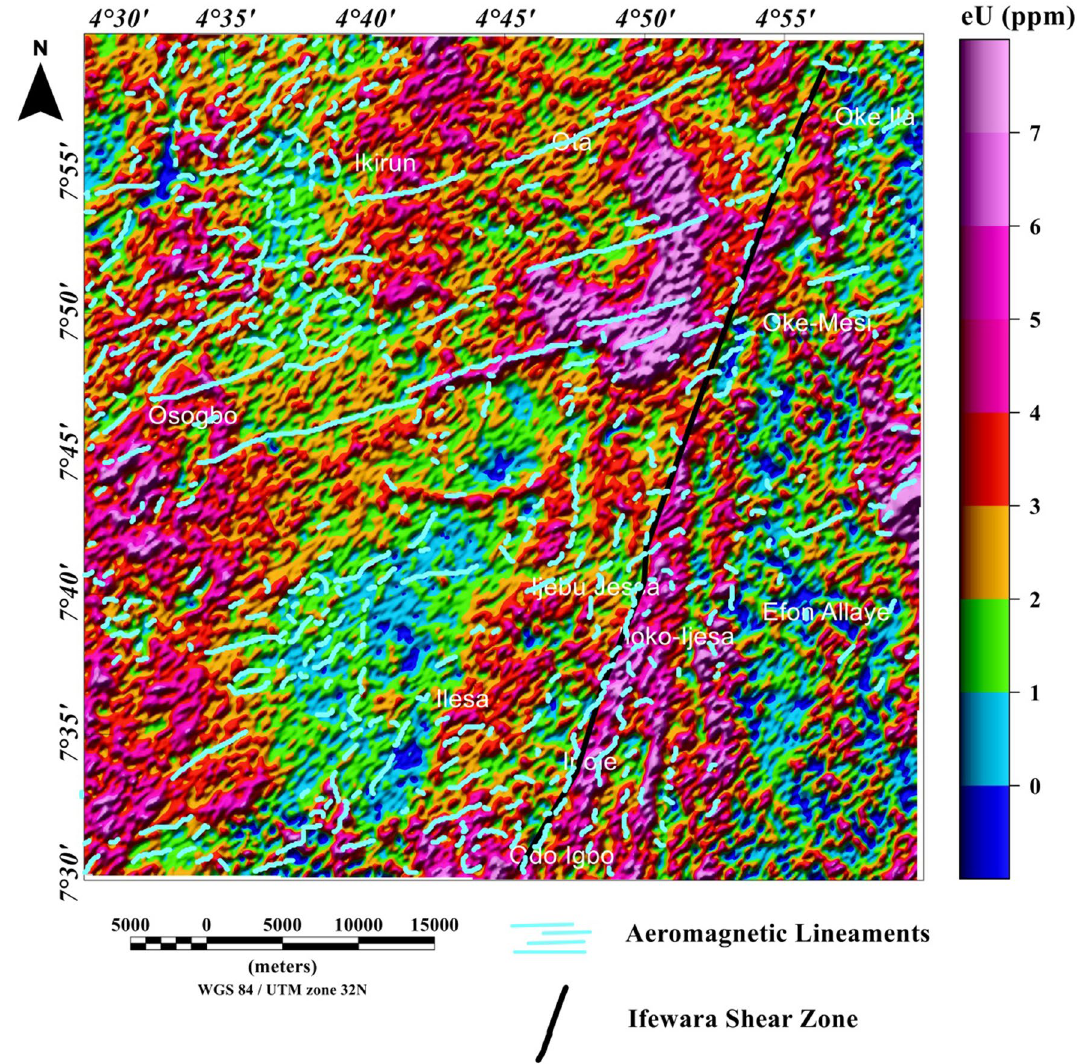
Figure 17. Map of uranium (ppm) data of the Ife-Ilesha schist belt with superimposed Ifewara fault zone extracted from the total gradient amplitude map presented in color-shaded relief, illuminated from the north- northwest direction. The north-northwest illumination (azimuth: 337.5 degrees and light angle: 45 degrees) enhances north-northeast lineaments. The figure was produced using Oasis Montaj Software version 8.3.3 (Website: https:// www. seequ ent.